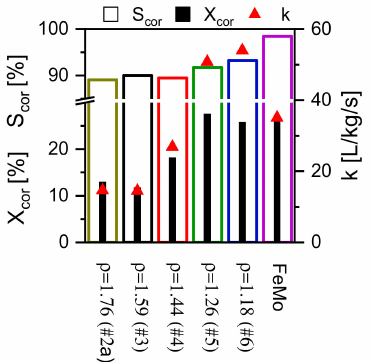
Figure 20. Observed first order rate constant and reversible byproduct corrected conversion and selectivities on single pellets of Mo/HAP with different densities and a FeMo pellet at 350 ◦ C in 300 NmL/min, 5 vol.% MeOH, and 10 vol.% O 2 in N 2 . Reproduced from [112] with permission from the Royal Society of Chemistry.